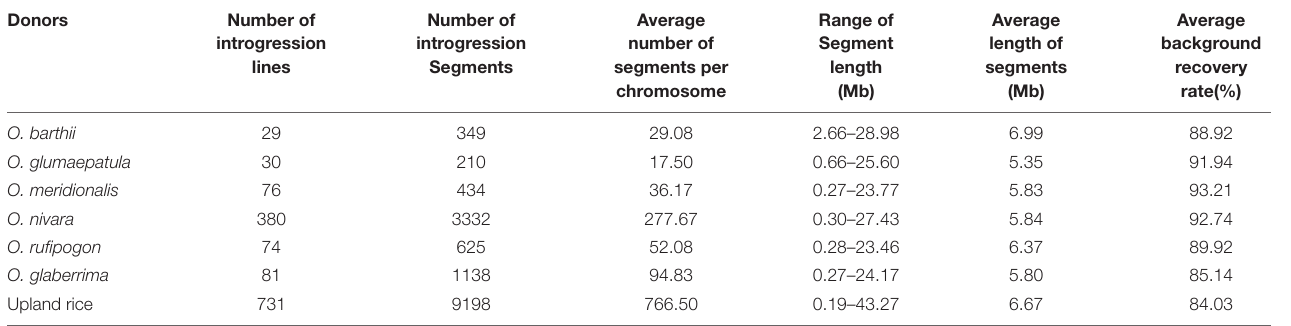
TABLE 2 | The characterization of introgression